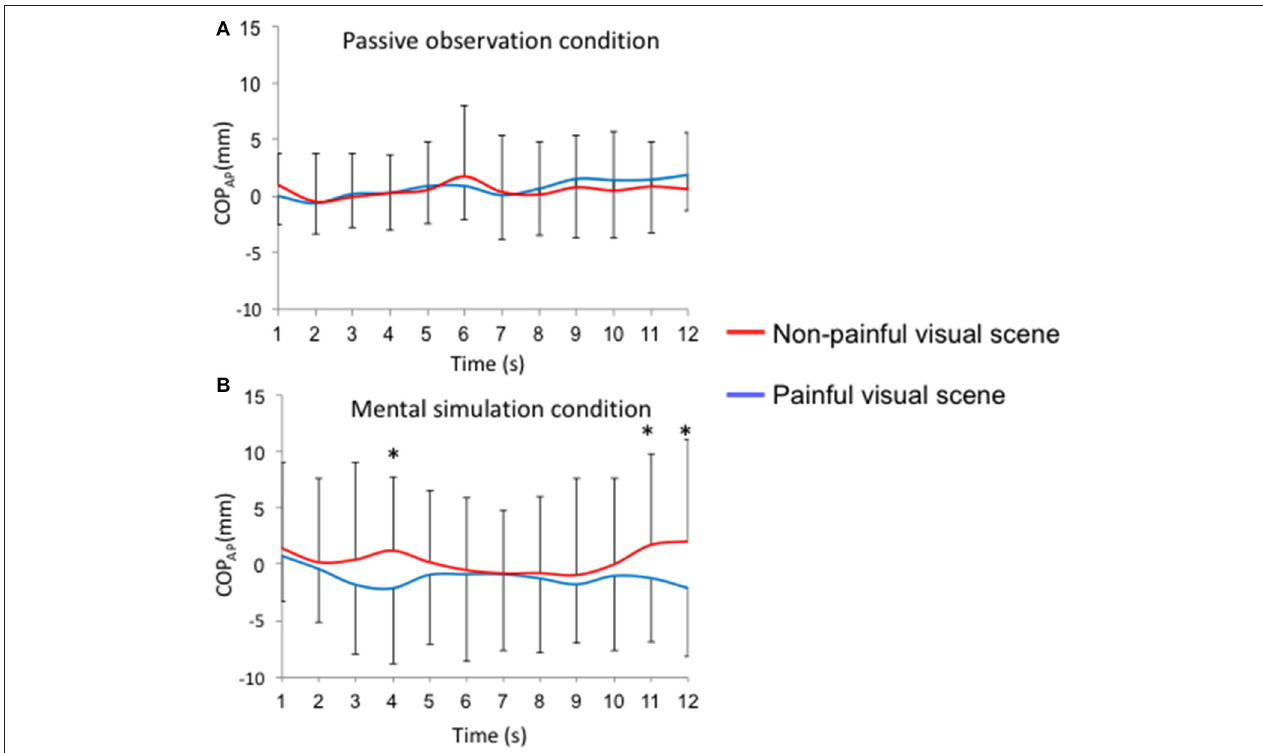
FIGURE 3 | Time-course of the anteroposterior position of the COP AP for each visual stimulus (painful vs. non-painful visual scenes). Mean sliding window (1s): (A) passive observation condition; (B) mental simulation condition, * p < 0.05.